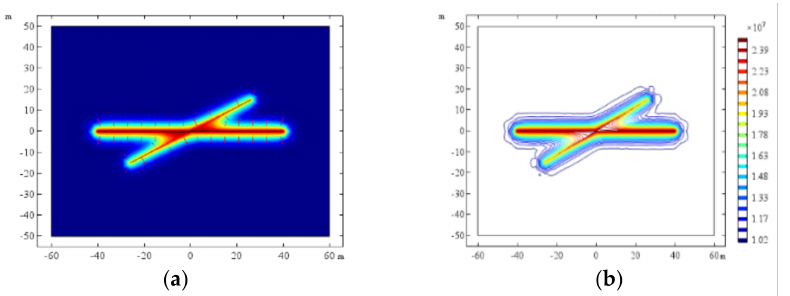
Figure 12. Case 9 calculation result. ( a ) Grout propagation pattern. ( b ) Distribution of grout propagation pressure